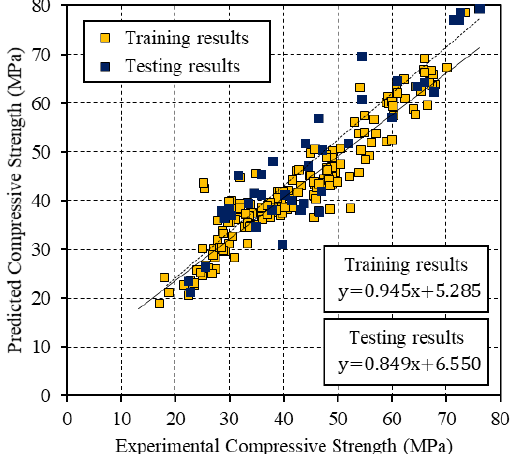
Figure 6. Comparison between the experimental CS and that predicted by the PSO-BP neural network.